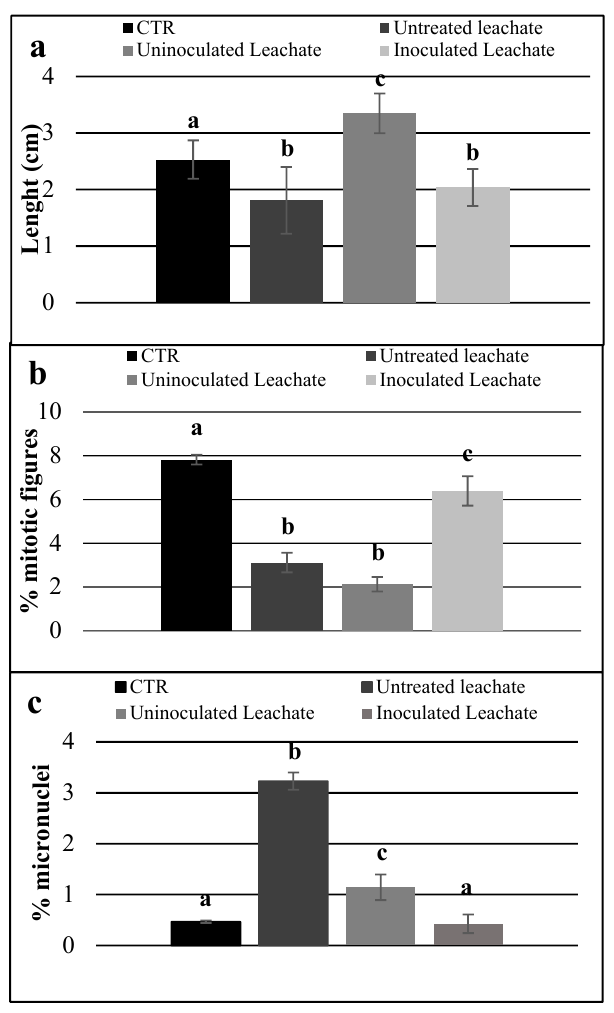
Figure 4. Panel ( a ) Phytotoxicity; ( b ) Cytotoxicity; ( c ) Genotoxicity of the old Cuio Depur WWTP leachate before and after the myco-based treatment. All the values are statistically different from the corresponding value at the untreated leachate (CTR) at the 1% ( p < 0.01). Bars represent the standard deviation (SD) among the three replicates of analysis. Statistically significant differences of the data compared to the control (deionized water) are indicated by letters on the top of the bars.